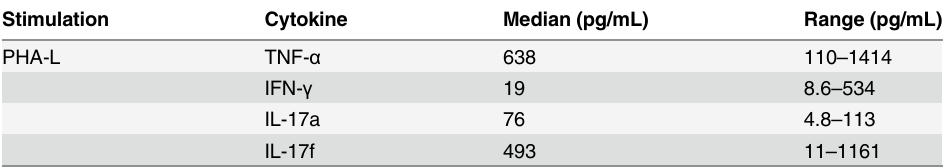
Table 2. Median and range of DMSO controls from PHA-L-stimulated PBMCs (n = 6 cultures in duplicates).